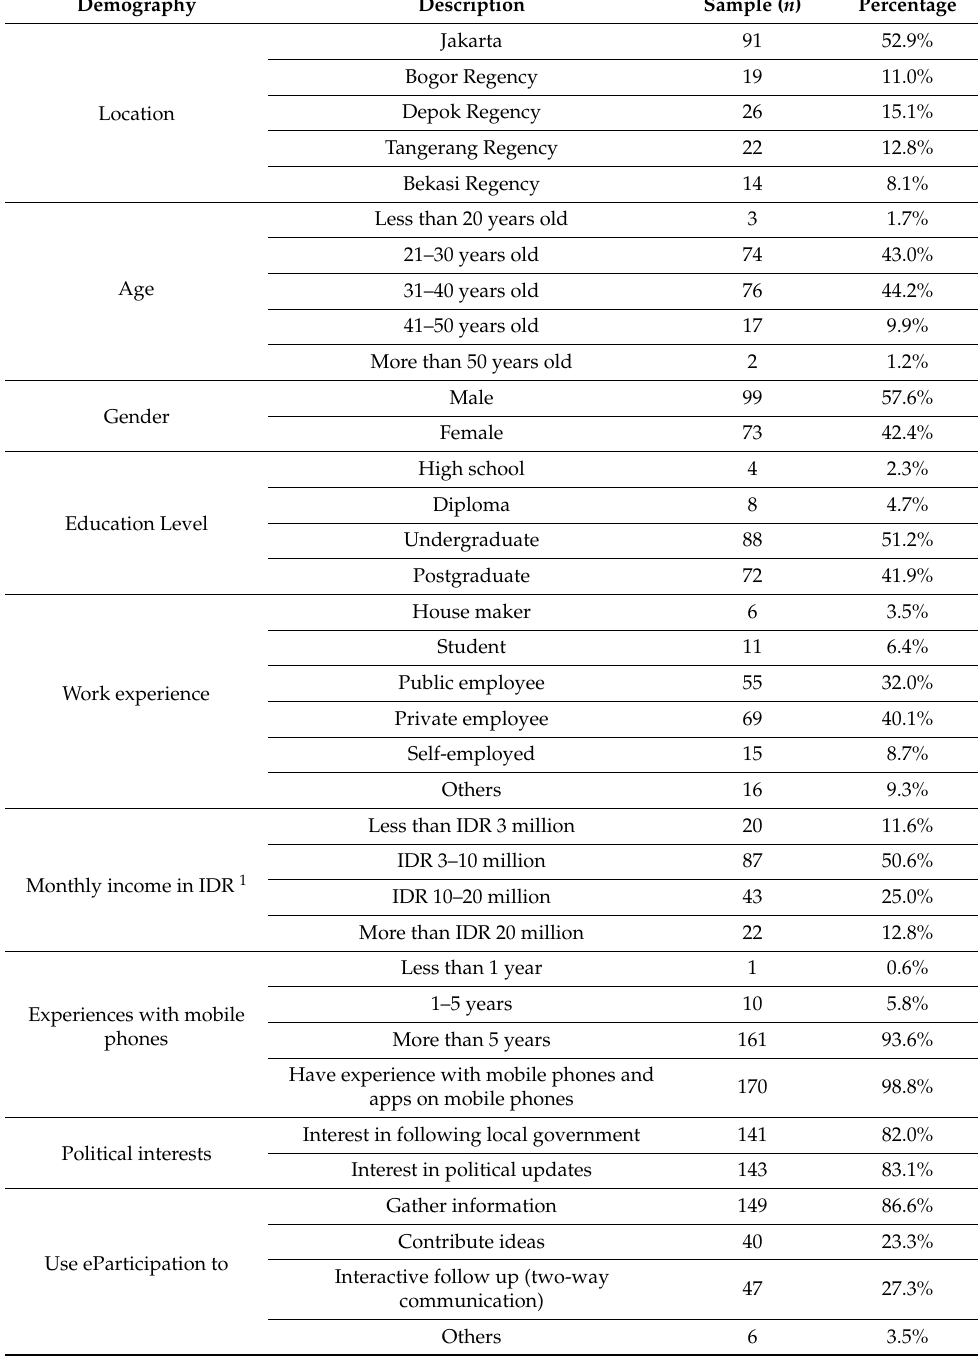
Table 2. Respondents’ demography